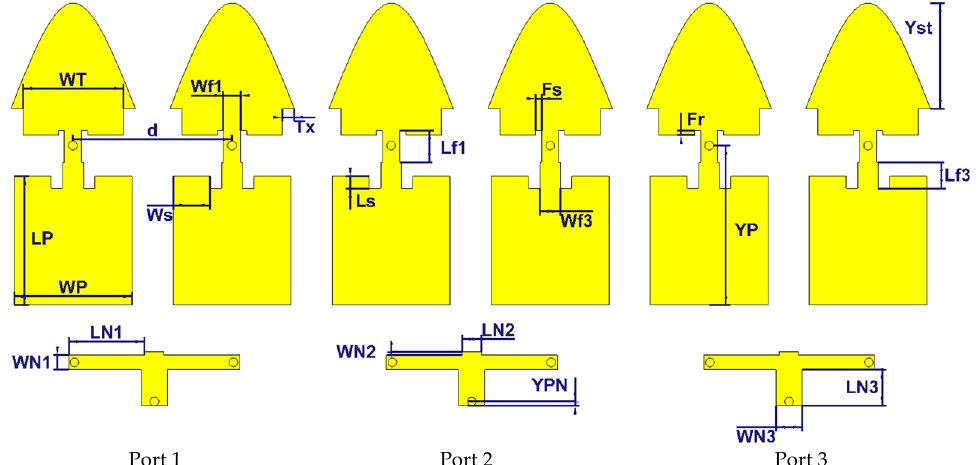
Figure 20. Configurations of the proposed 2 × 6 antenna array with the feeding network. The simulated S-parameters of the array are shown in Figure 21. The simulated − 10 dB bandwidth is from 5.15 to 6.18 GHz, or about 17% for a center frequency of 5.8 GHz. A low mutual coupling between the three ports is observed, below − 25 dB in the whole operation band.